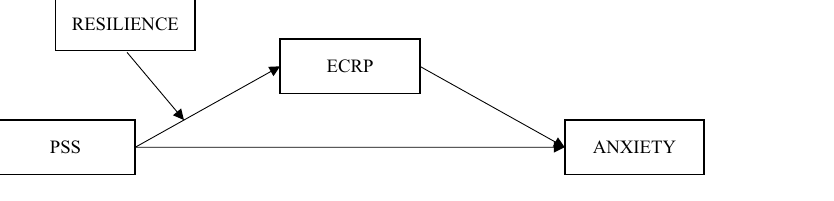
Figure 1. Diagram of the theoretical